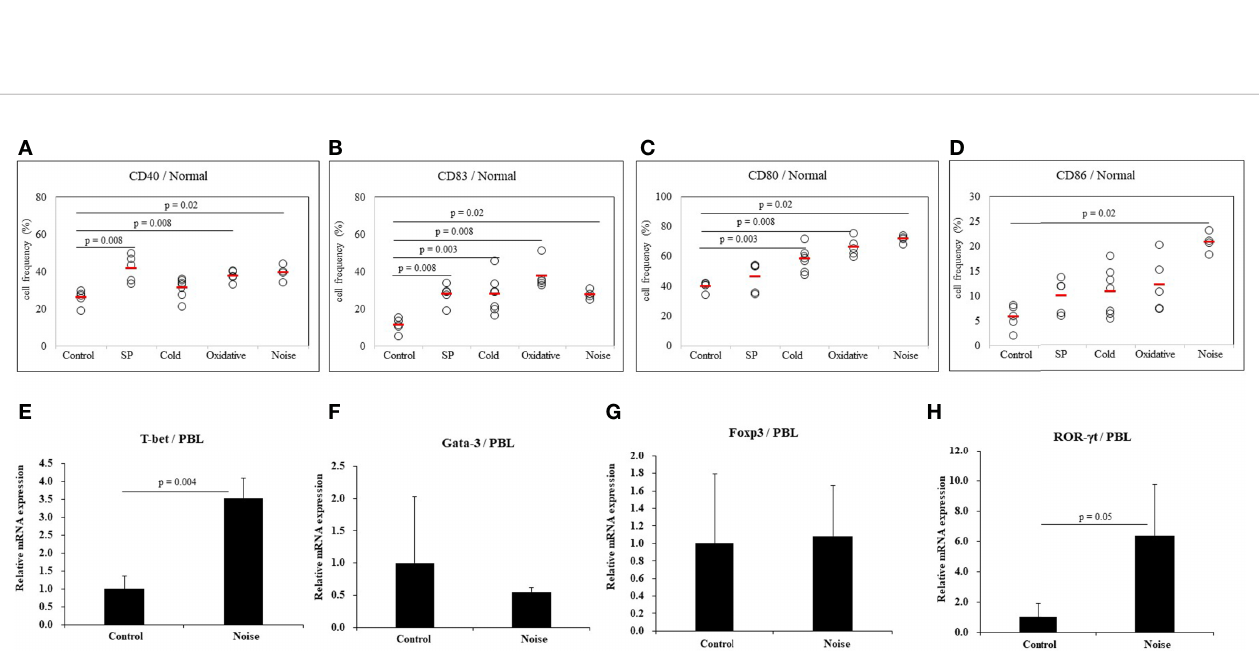
FIGURE 4 | Expression levels of dendritic cell activation markers in normal mice after stress treatment. Frequencies of DC activation molecules CD40+, CD83+, CD80+, and CD86+ cells in normal mice after stress treatment were analyzed by FACS analysis (A – D) . Substance P (SP) was used for anxiety stress, 4°C temperature was used for cold stress, xanthine sodium salt was used for oxidative stress, and 77dB sound was used for noise stress induction. For statistical analysis, Mann-Whitney U test was performed. Cellular transcription factor mRNA expression levels in PBLs of normal mice exposed to noise stress were analyzed by real time-PCR (E – H)